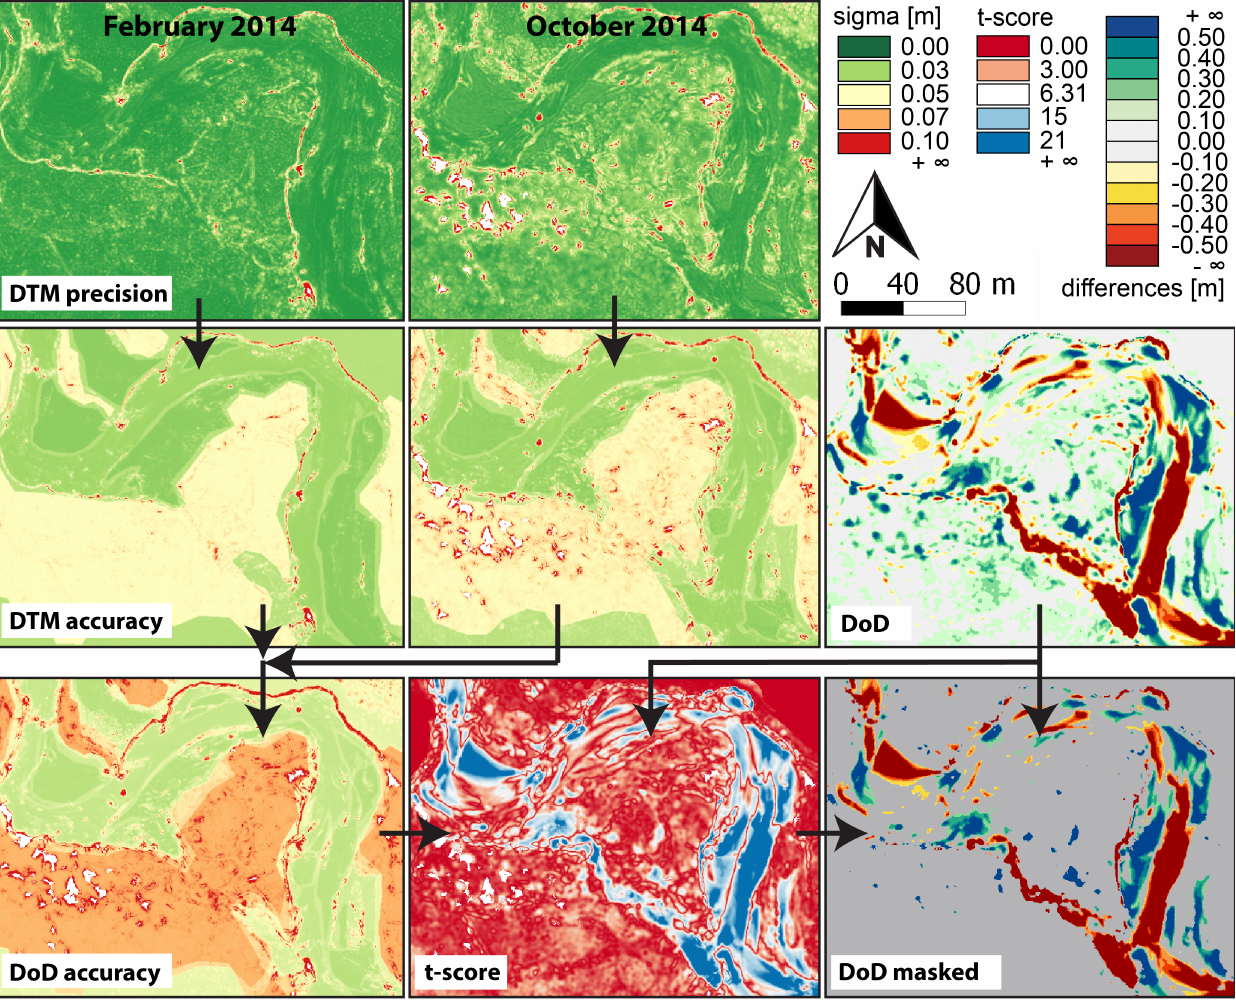
Figure 9. DoD accuracy estimation; first row: DTM precision maps and color bars; second row: DTM accuracy maps and unmasked DoD; last row: combined DoD accuracy, student’s t -score map, masked DoD thresholded at 95% confidence